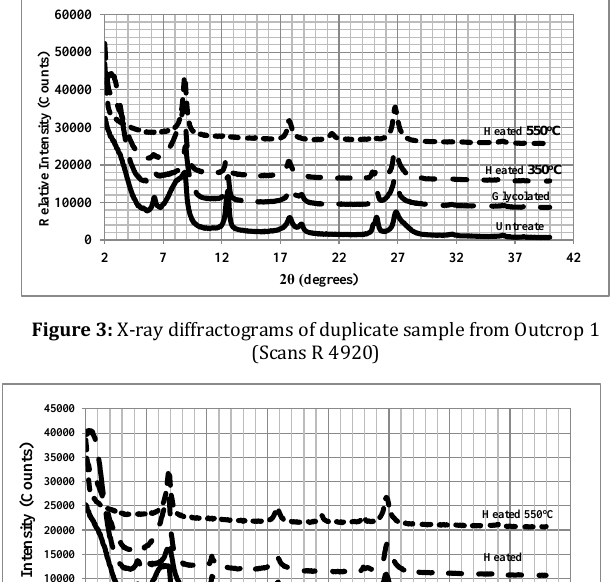
Table 8: Criteria for identification of clay (and non-clay) minerals in